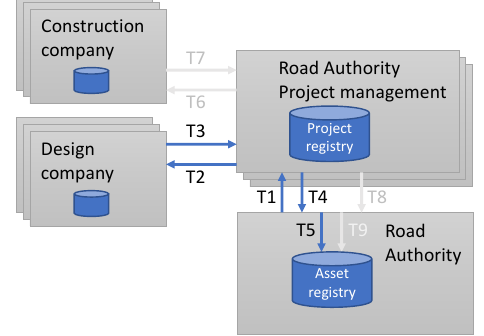
Figure 5. The information exchange (transactions) for the use case from the asset management to design, then to construction and back to asset management (Malmkvist et al.,